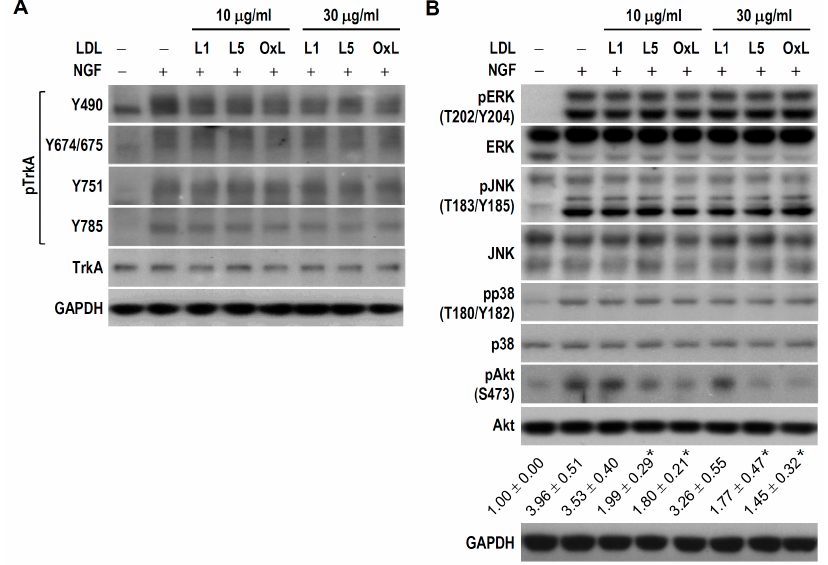
Figure 7. L5 decreases the level of phospho-Akt (pAkt), but not pTrkA and pMAPKs, in NGF-treated PC12 cells. ( A ) Cultures were treated with L1, L5, or oxLDL (OxL) at 10 or 30 µ g/mL for 1 h, followed by NGF (50 ng/mL) addition for another 20 min. Untreated cells were used as a control. Western blotting was used to detect the expression of TrkA phosphorylated at various tyrosine sites and total TrkA protein. GAPDH was a protein loading control. Representative blots selected from one of four independent experiments are presented; and ( B ) Alternatively, western blotting was performed to detect pERK, ERK, pJNK, JNK, pp38, p38, pAkt, and Akt expression. Quantitative values of pAkt relative to the level of untreated control (assigned a value of 1) are expressed; the means ± SEM from four independent experiments are shown below the representative blots. * p < 0.05 vs. NGF alone.